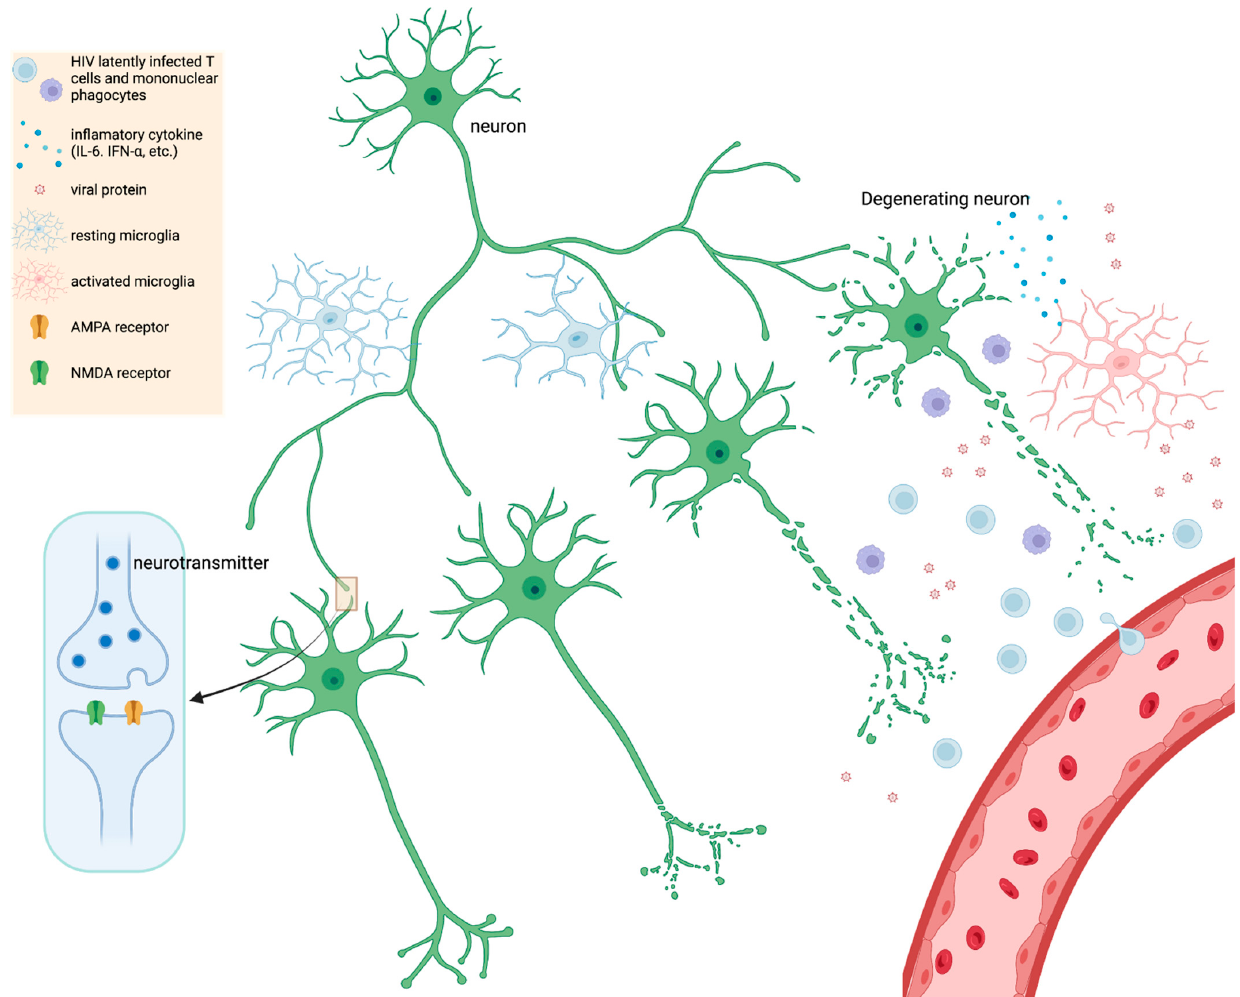
Figure 1. A simple schematic illustrating HIV infection within the CNS. HIV latently infects T cells and mononuclear phagocytes that migrate across the BBB; various stimuli trigger reactivation of viral latency in CNS. Upon activation, elevated levels of viral proteins (gp120, Nef, Tat) trigger resting microglia, which further leads to proinflammatory cytokine secretion, such as IL-6, IFN- α , etc. Chronic inflammation and HIV protein expression contribute to neurocognitive impairment (NCI) and injury of synapses and dendrites (inset diagram). Synaptodendritic injury may include less branching of dendrites, shortening of neurites (axons and dendrites), or downregulation of glutamate receptors such as NMDA or AMPA. In severe but rarer cases of HIV-induced inflammation and NCI, death of neurons can occur. Figure created in BioRender.